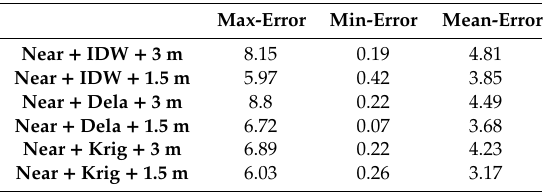
Table 2. Positioning error statistics considering the near relation.